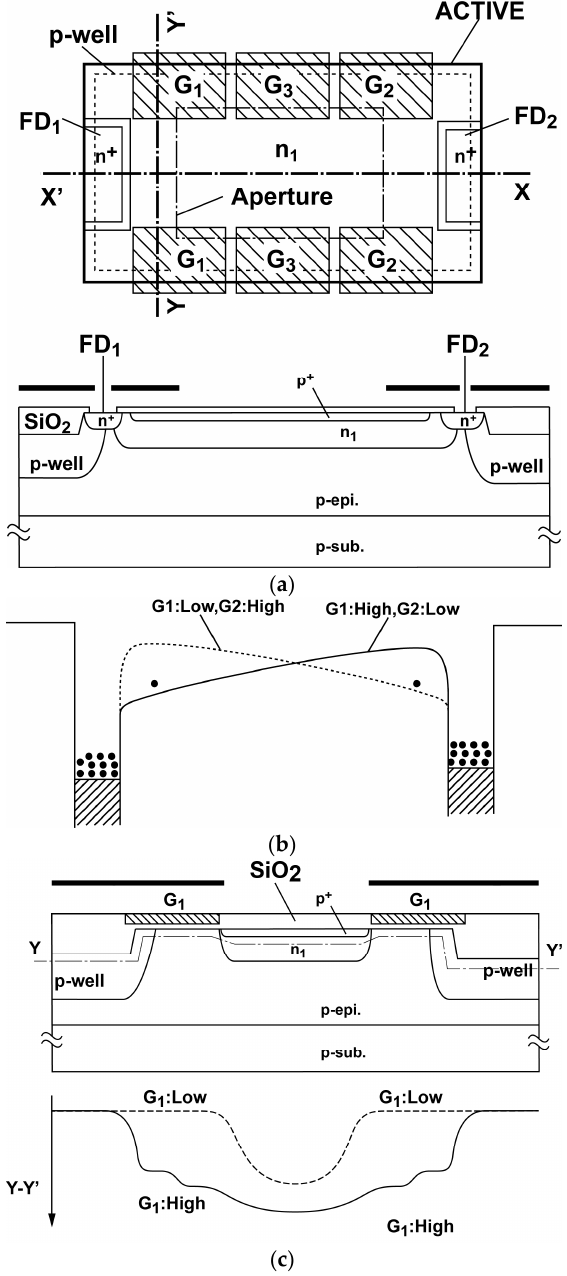
Figure 5. Lateral Electric Field Charge Modulator (LEFM): ( a ) top view and cross-sectional view for X-X’ ( b ) potential profiles for photo-electrons transfer ( c ) cross-sectional view and potential profile for Y-Y’.